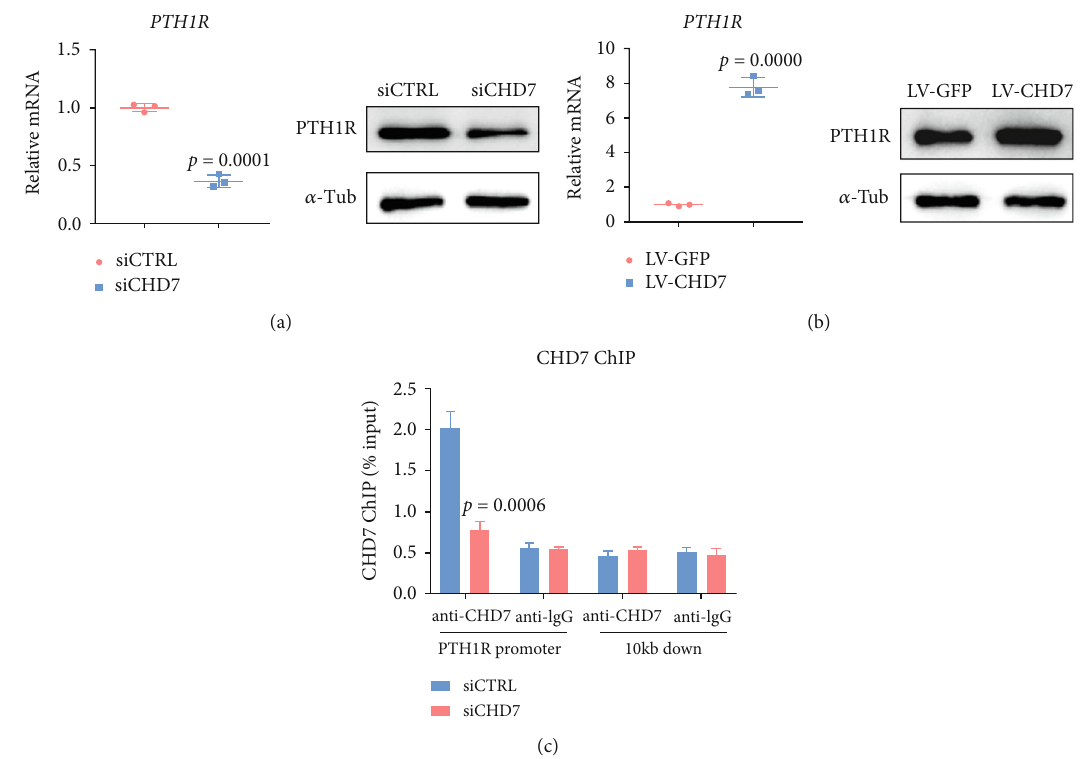
Figure 5: CHD7 regulates the expression of PTH1R. (a) qRT-PCR and Western blot of the PTH1R expression after CHD7 depletion. (b) qRT-PCR and Western blot of the PTH1R expression after the CHD7 overexpression. (c) Anti-CHD7 ChIP assay. CHD7 can bound to the promoter region of PTH1R, and the ChIP signaling was signi fi cantly suppressed after CHD7